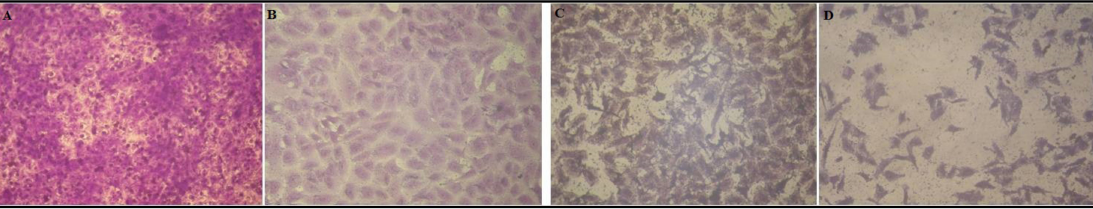
Figure 3. Microscopic observation of the cytopathic effects (morphological alterations) of the prostate carcinoma cells (PC3) treated with Opuntia ficus-indica seed oil concentrations ( A ) Control; ( B ) 20 µ g/mL; ( C ) 100 µ g/mL; ( D ) 500 µ g/mL. Figure is at 100 ×